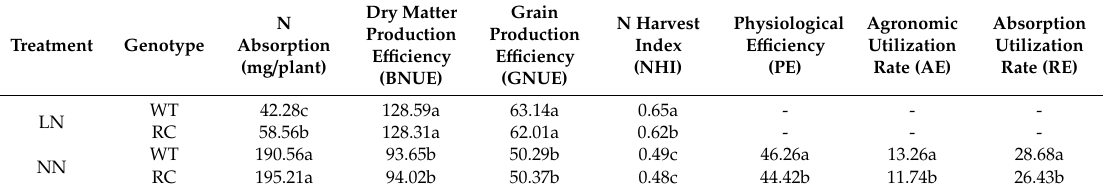
Table 2. N-use e ffi ciency of rice under di ff erent nitrogen treatments in buckets.